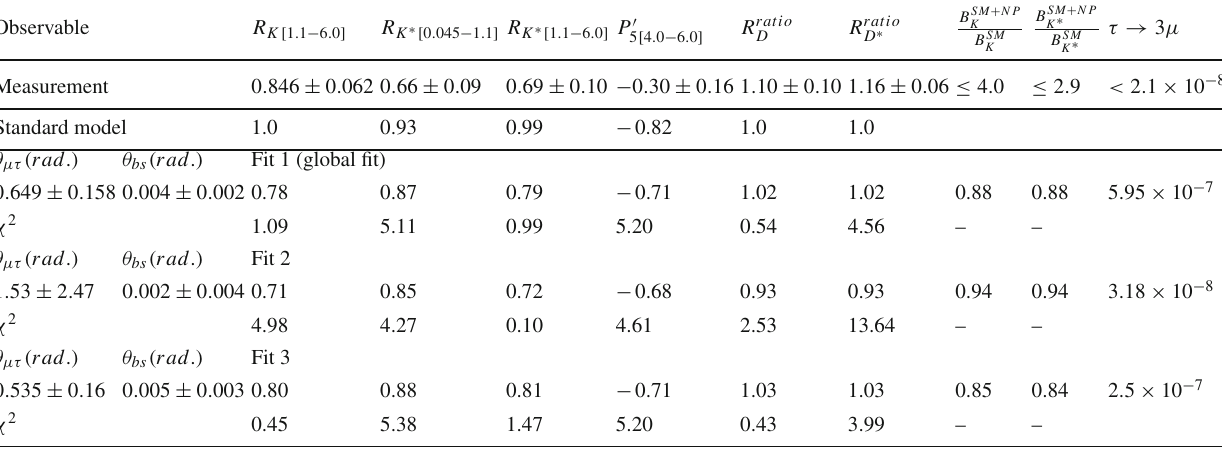
Table 1 Best fit values of the mixing angles in vector boson model. For Fit 1, dof=123, χ 2 / dof = 1 . 00 Observable